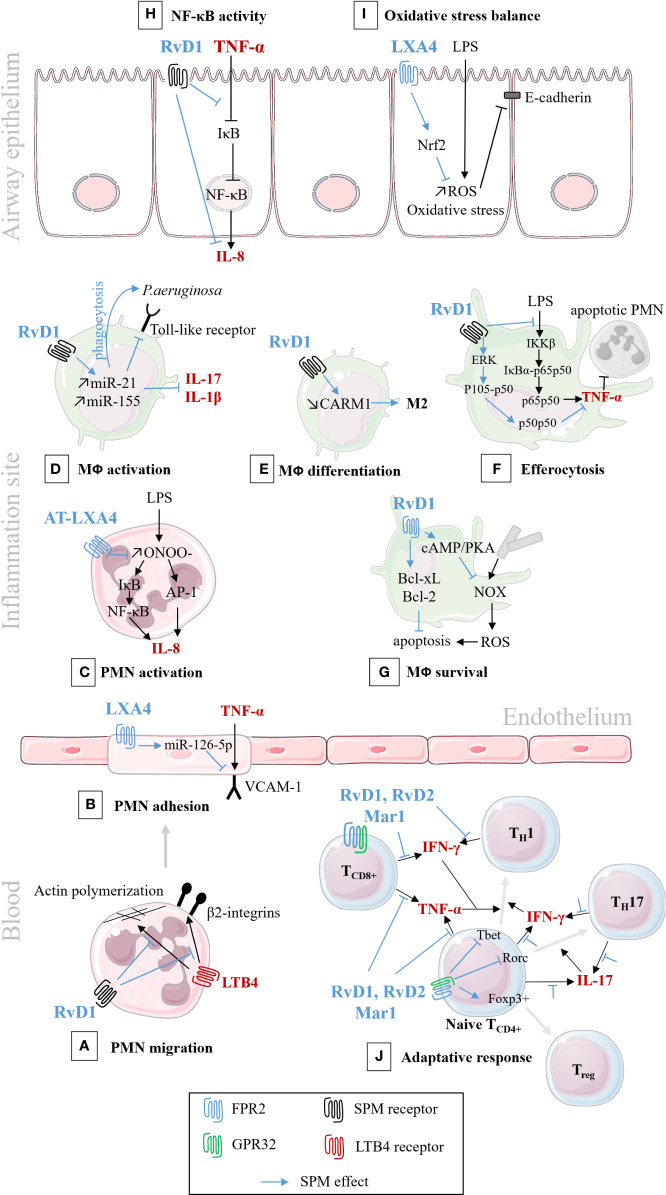
Schematic illustration of SPMs cellular pathways involved in the resolution of inflammation/infection. In black: pro-inflammatory pathways; In blue: bioactions of SPM. (A) RvD1 analog down-regulates the migration of PMNs isolated from human peripheral blood, by decreasing actin polymerization, and blocking LTB4-regulated adhesion molecules, 2 integrins. (Krishnamoorthy et al., 2010); (B) LXA4 down-regulates VCAM-1 receptor and PMN adhesion to human endothelial cells (Codagnone et al., 2017); (C) AT-LXA4 (15-epi-LXA4) down-regulates IL-8 synthesis and secretion, in human PMNs isolated from venous blood (Jozsef et al., 2002); (D) RvD1 down-regulates toll-like receptor (TLR), cytokines synthesis and enhances phagocytosis of murine lung macrophage (Codagnone et al., 2018); and enhances phagocytosis and bacterial killing in human CF alveolar macrophage (Ringholz et al., 2018); (E) RvD1 stimulates murine macrophage differentiation from M1 to M2 state (Recchiuti et al., 2014); (F) RvD1 stimulates efferocytosis of apoptotic PMNs, through the regulation of NF-κB pathways, in murine macrophage (Lee et al., 2013); (G) RvD1 inhibits ROS production and increases murine macrophage survival after efferocytosis (Lee and Surh, 2013); (H) RvD1 inhibits cytokines secretion by preventing IκB degradation in CF human airway epithelial cell (Ringholz et al., 2018); (I) LXA4 inhibits oxidative stress and protects E-cadherin, in human airway epithelial cell (Cheng et al., 2016); (J) RvD1, RvD2, and Mar1 regulate the adaptive response, enhance the differentiation to Treg rather than TH1 and TH17, in human peripheral blood lymphocytes (Chiurchiù et al., 2016).